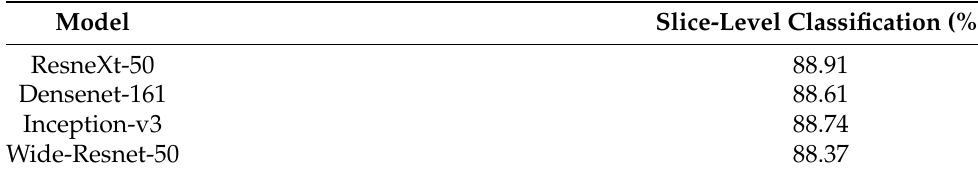
Table 4. Validation of slice-level classification results using multi-tasks learning with four backbone CNN architectures (ResneXt-50, Densenet-161, Inception-v3, and Wide-Resnet-50) [6].